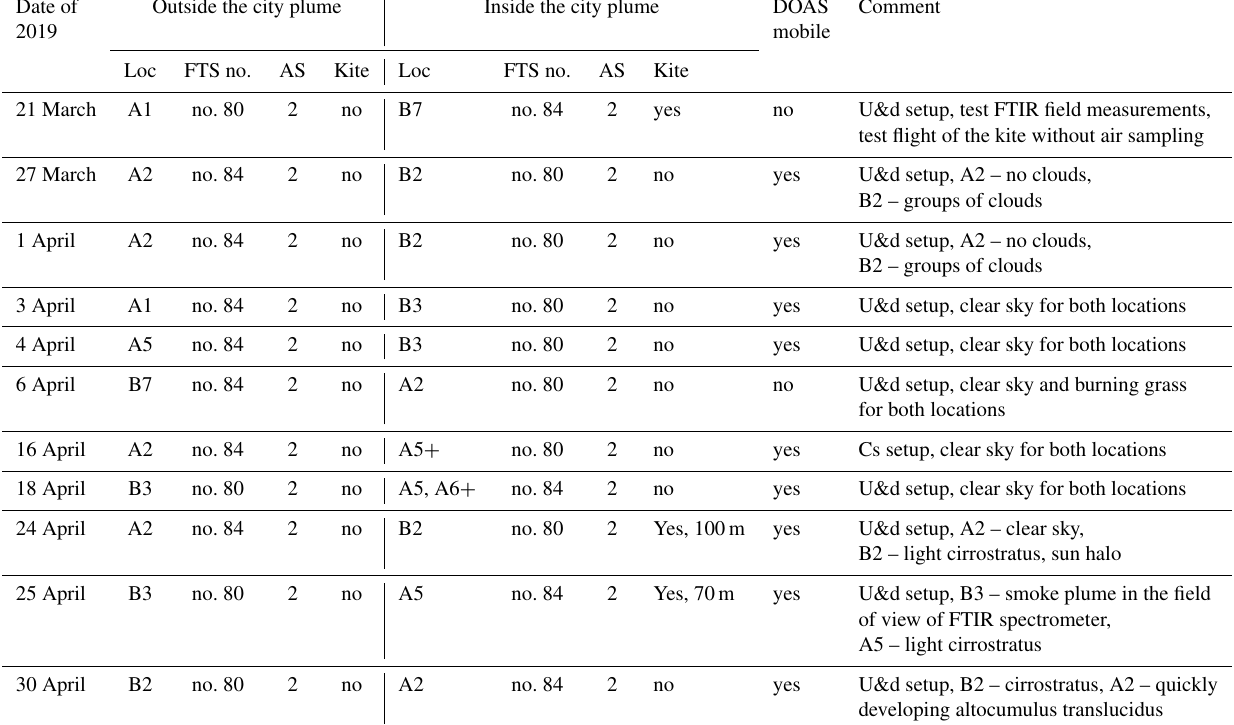
Table A1. EMME-2019 observation details: the field experiment setup (up- and downwind “u&d” or cross-sectional “cs”), the FTS location (Loc), the FTS identifier (FTS no.), the number of bags of air samples (AS), indication of the kite launch and the corresponding air sampling